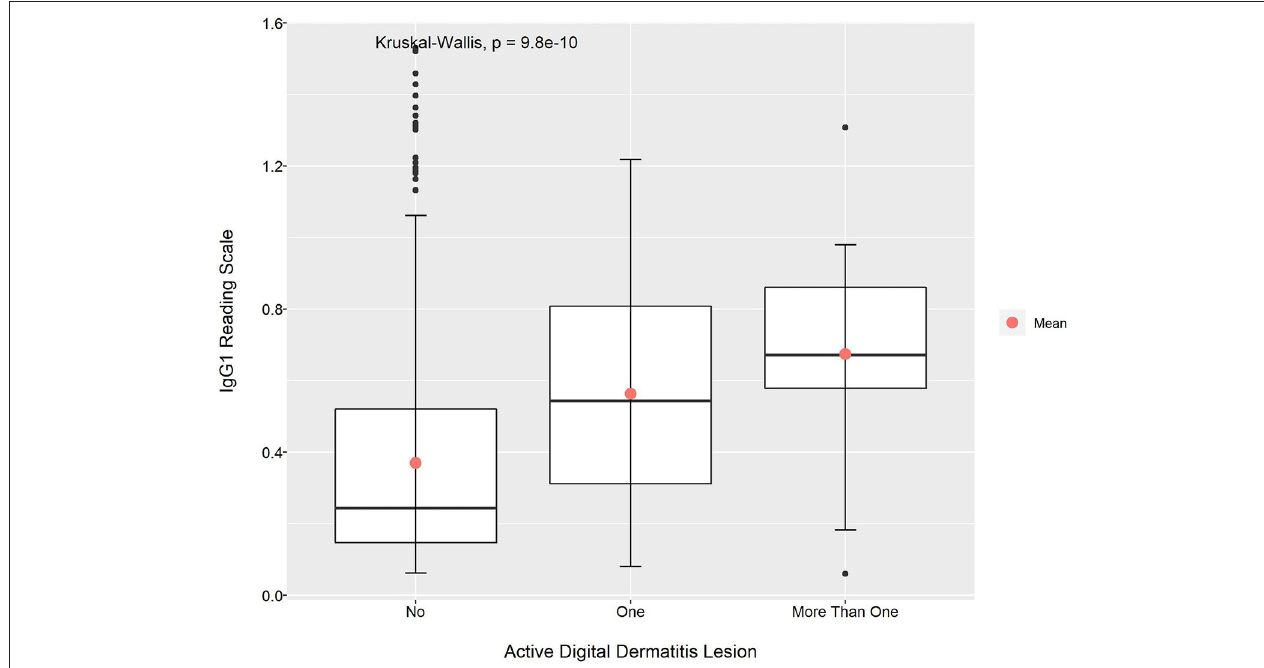
FIGURE 3 | Mean absorbance reading for IgG1 anti- Treponema antibodies according to the presence of active DD lesion.